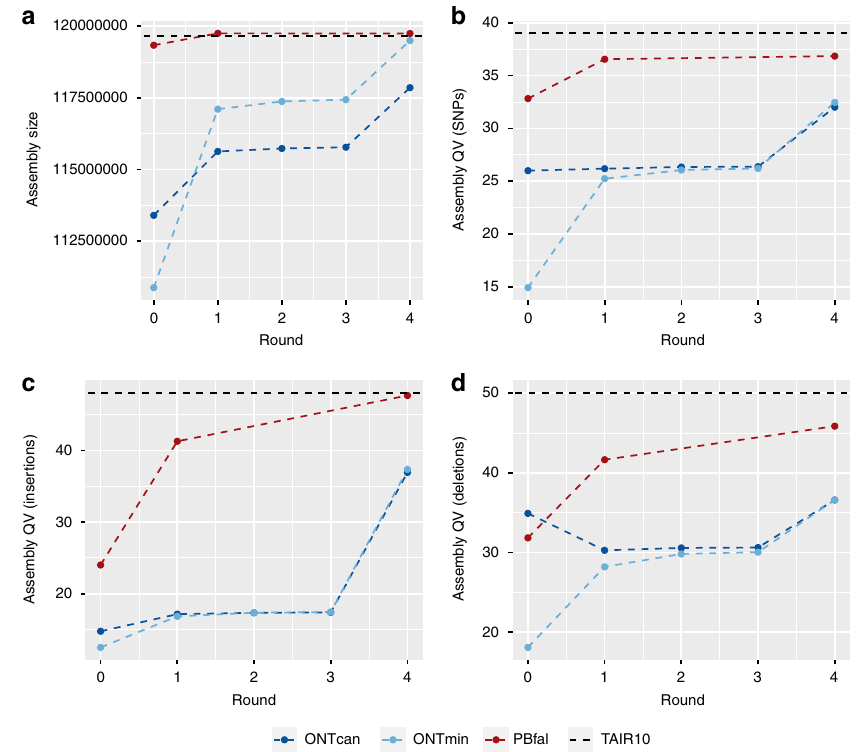
Fig. 2 Quality comparisons of single molecule assemblies and TAIR10 reference assembly. a Final assembled genome size versus assembly rounds. b Assembly quality based on short sequence artifacts versus rounds. c Assembly quality based false-insertions versus rounds. d Assembly quality based false-deletions versus rounds. Assembly types: Oxford Nanopore MinION, ONT; PacBio Sequel, PB; miniasm, min; Falcon, fal; Canu, can; reference genome, TAIR10. Polishing rounds PacioBfal: 0 = raw assembly; 1, arrow 1x; 4, pilon